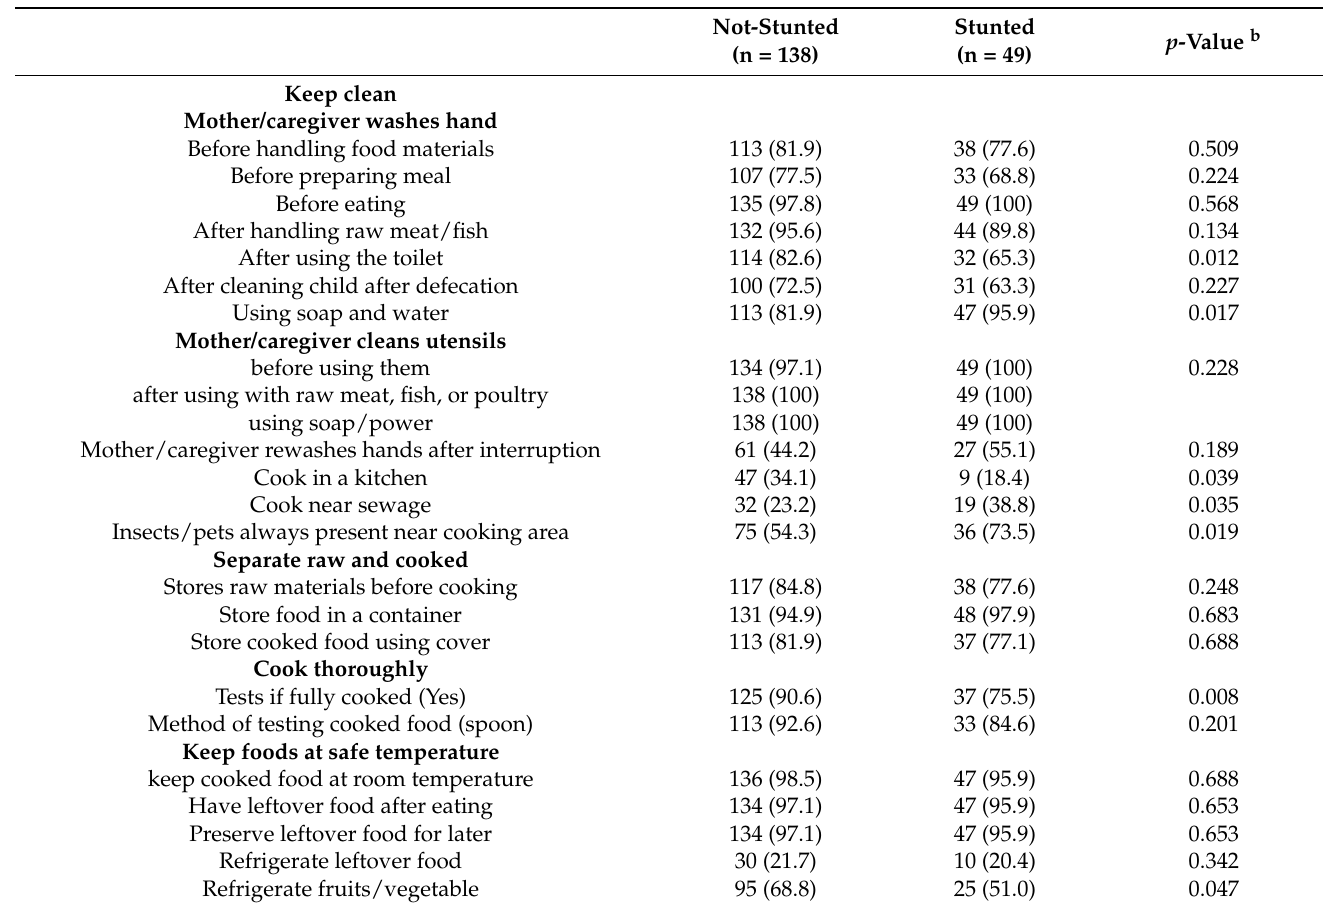
Table 3. Food safety practices a according to stunting